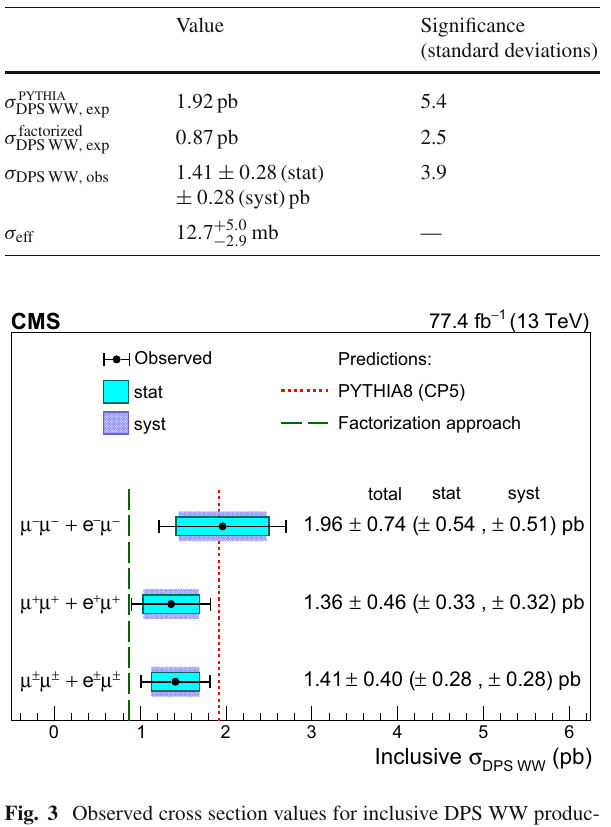
Fig. 3 Observed cross section values for inclusive DPS WW produc- tion from the two lepton charge configurations and their combination. These values are obtained from the extrapolation of the observed DPS W ± W ± cross section to the inclusive WW case. The statistical and sys- tematic uncertainties are shown using shaded bands. The predictions from pythia and from the factorization approach are represented with the red dotted and green dashed lines,